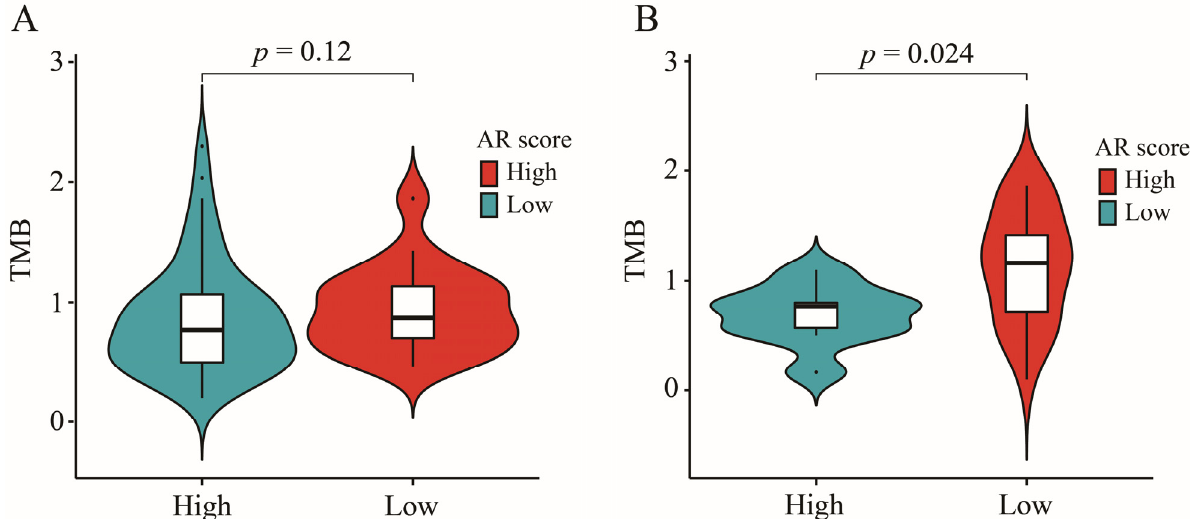
Figure 8. The role of IDH1 mutation on relationship between AR-related signature and TMB. ( A ) The comparisons of TMB between high- and low-AR patients with IDH1 mutation. ( B ) The comparisons of TMB between high- and low-AR patients with wild-type IDH1.